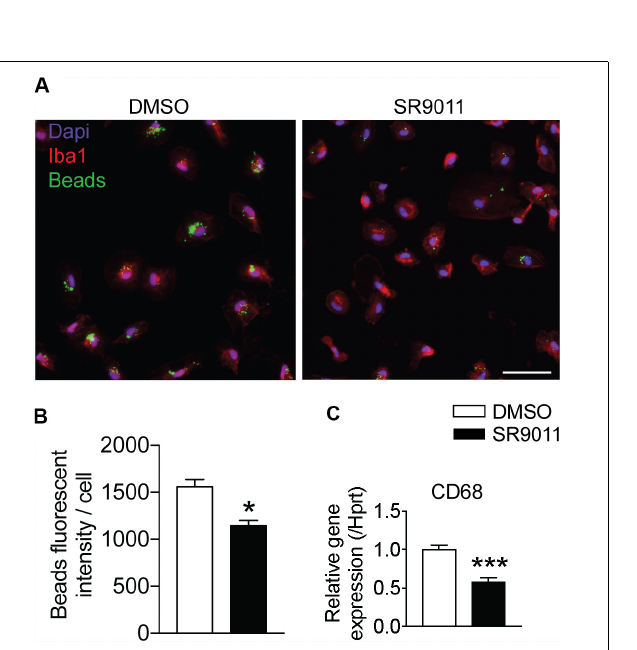
FIGURE 4 | The effect of SR9011 on palmitic acid induced inflammatory responses in microglia. Relative gene expression of cytokines in primary microglia treated with SR9011 or DMSO for 12 h followed by 50 µ M palmitic acid or BSA treatment for 12 h ( n = 4 per group). Palmitic acid treatment increases Il6 (A) , Il1 β (B) , and Gm-csf (C) , which are inhibited by SR9011. Palmitic acid treatment has no profound effect on the expression of Tnf α (D) and Ccl2 (E) , while SR9011 decreased Ccl2 expression with and without palmitic acid treatment (E) . p < 0.05* vs DMSO + BSA and p < 0.05 # vs DMSO + PA.